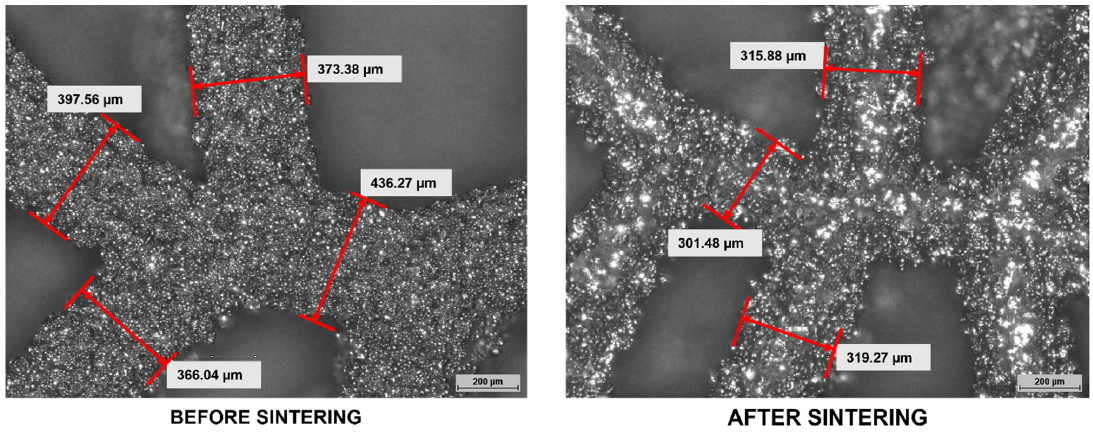
Figure 6. The dimensions of the struns of the Voronoi structure obtain from optical microscopy.